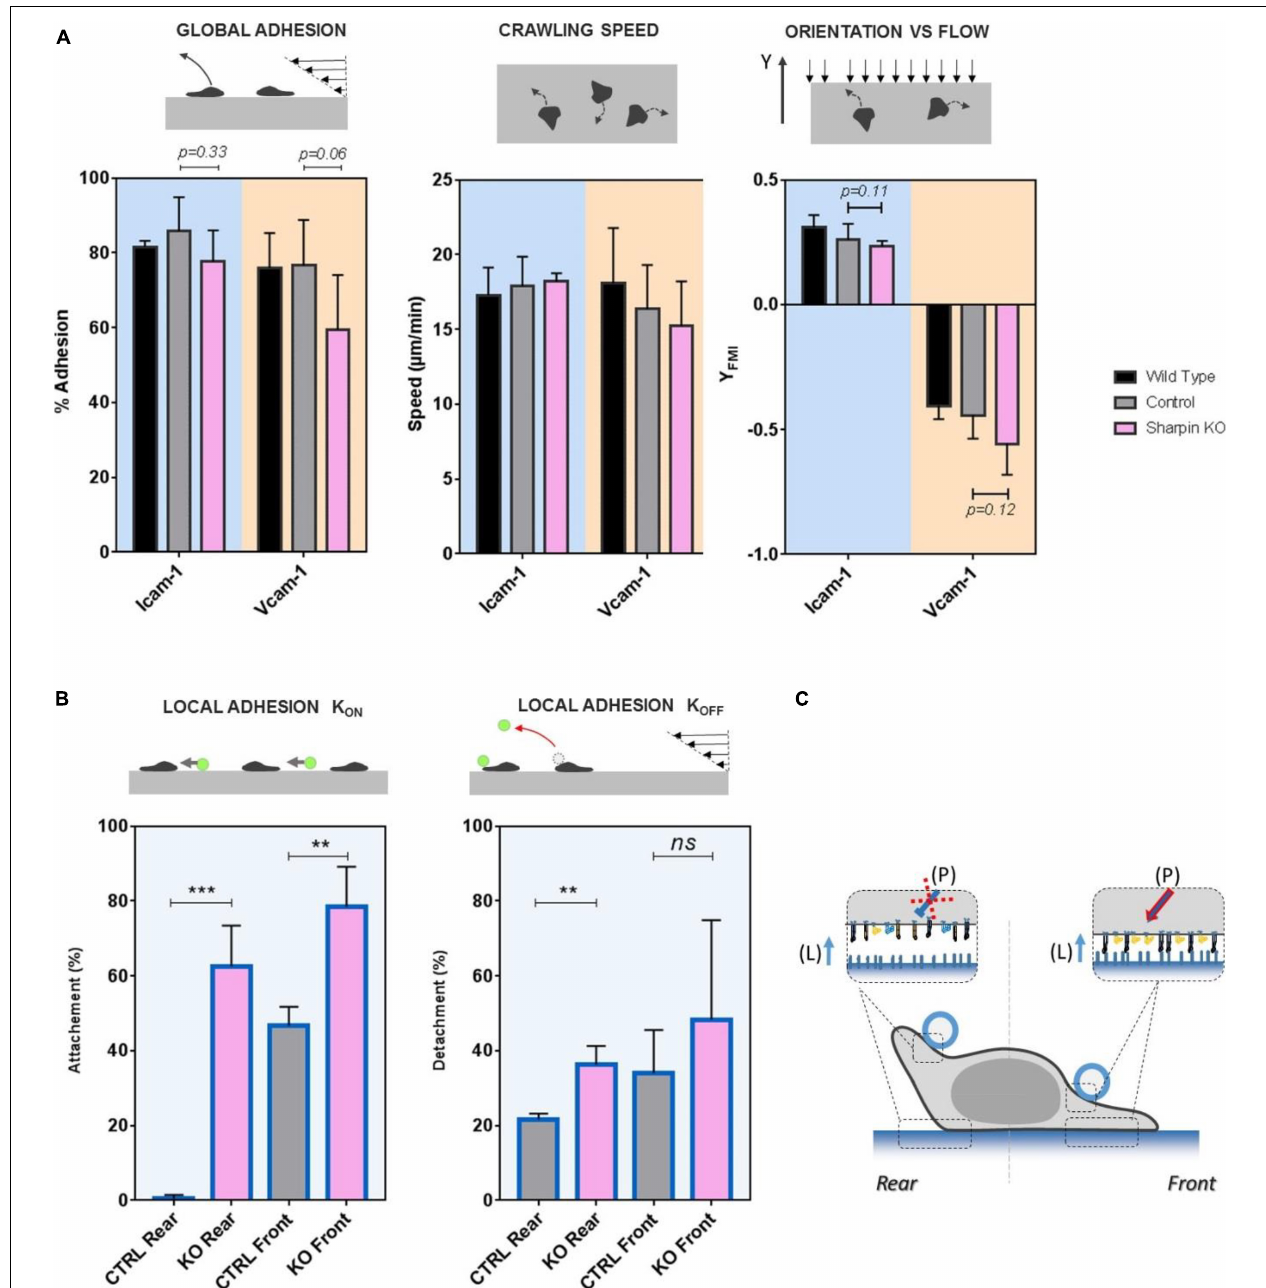
FIGURE 5 | SHARPIN modulates effective adhesion in leading and trailing edges and with opposite effect on LFA-1 and VLA-4. (A) Global adhesion experiments. Left—percentage of cells adhered after 5 min of shear stress at 4 dyn/cm 2 . Center—speed of crawling cells. Right—forward migration index in the direction of flow ( > 0 against, > 0 with) at 4 dyn/cm 2 . Substrates are coated with CAM-1 at 1200 molecules. µ m − 2 . Background is blue for surface ICAM-1 and orange for VCAM-1. Color bar is black for wild-type cells, gray for control cells transfected with unspecific RNP complexes, and pink for Sharpin-deficient cells. Nexp = 3. Ncell > 200 per experiment. Error bars are standard deviations for independent experiments. P -values according to Student t -test. (B) Local adhesion experiments. Left—attachment probability and right—detachment after 40 s of flow of beads with ICAM-1 at 2400 molecules. µ m − 2 on the rear or front of cells crawling on substrates coated with ICAM-1 at 1200 molecules. µ m − 2 . Gray for control cells transfected with unspecific RNP complexes and pink for Sharpin-deficient cells. Nexp = 3. Ncells > 30. Error bars are standard deviations for independent experiments. ** P < 0.01 and *** P < 0.001, with respect to unpaired Student t -test. (C) Cartoon illustrating that perturbation in Sharpin-deficient cells. Integrins are represented in orange for VLA-4 and blue for LFA-1, in their high-affinity and extended conformation (filled) and low-affinity bended conformation (hollow). The red cross indicates that the inhibiting signal of LFA-1 is diminished in cell rear and the red arrow that the activating signal is enhanced in cell front. Letters in brackets indicate the origin of the signal to integrin either from internal polarization signaling (P) or ligand presented by a substrate (L). Error bars are standard deviations for independent experiments. ** P < 0.01 and *** P < 0.001, with respect to unpaired Student t -test. Number of independent experiments Nexp = 3. Number of events per experiment Ne > 100 for attachment and > 40 for detachments.